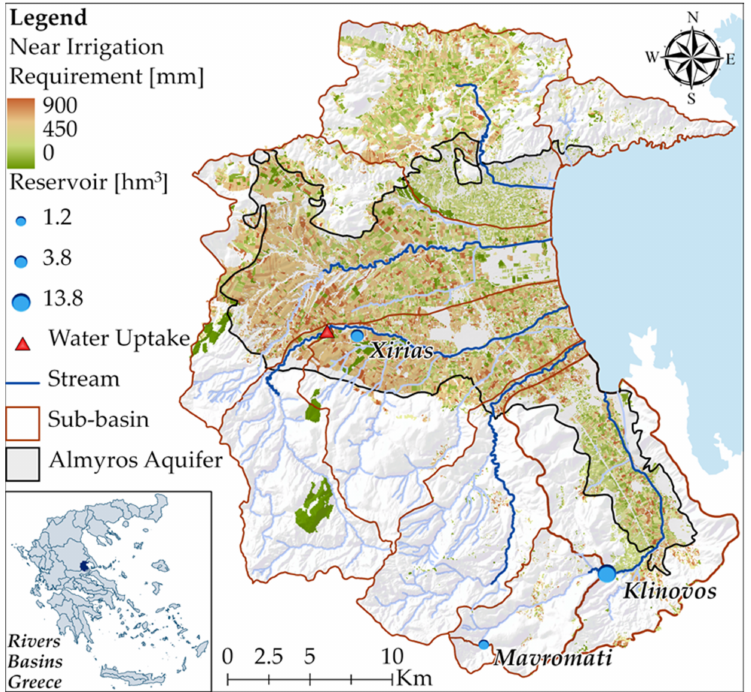
Figure 1. Map of Almyros basin, aquifer, sub-watersheds, irrigated agricultural areas, and location of the Xirias reservoir (under construction), the Klinovos reservoir (planned), and the Mavromati reservoir (constructed—not operated).